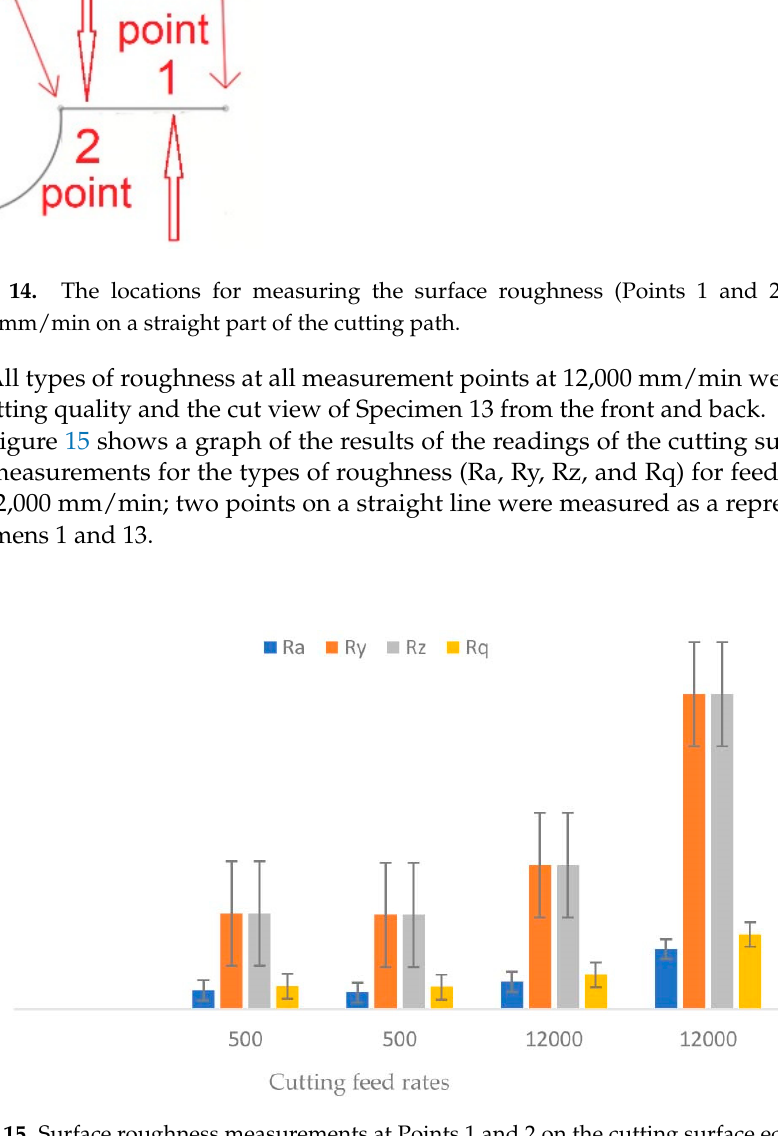
Figure 15. Surface roughness measurements at Points 1 and 2 on the cutting surface edge at 500 and 12,000 mm/min and 30 A. When interpreting the graphs, it was found that all the readings for Points 1 and 2 with the lowest feed rate had small values at 500 mm/min and showed a lower surface roughness and a higher cutting surface quality. The readings for Points 1 and 2 at the maximum at 12,000 mm/min were large and showed a greater surface roughness. The lowest reading of all types of roughness for specimen 1 at Point 2 was 2.5 µm, which showed that these parameters yielded the highest cutting quality at the lowest cut- ting feed rate. The graph above also shows that all the readings of the roughness measurements varied to some extent from low to high and from the lowest cutting feed rate to the highest feed rate.